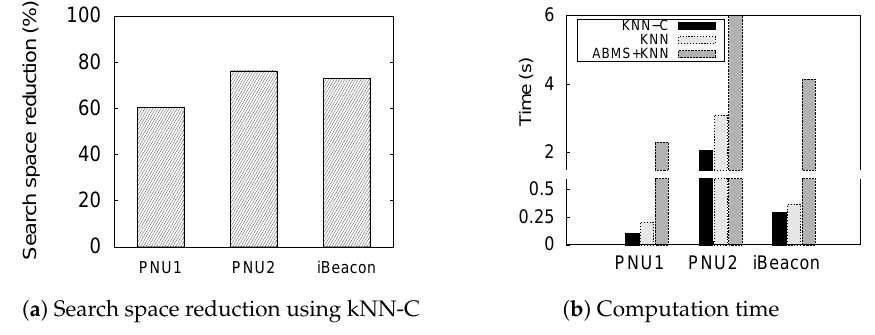
Figure 11. Efficiency of kNN-based methods to predict a semantic position.